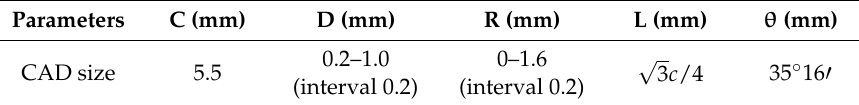
Table 1. Geometrical parameters of the diamond lattice structures .